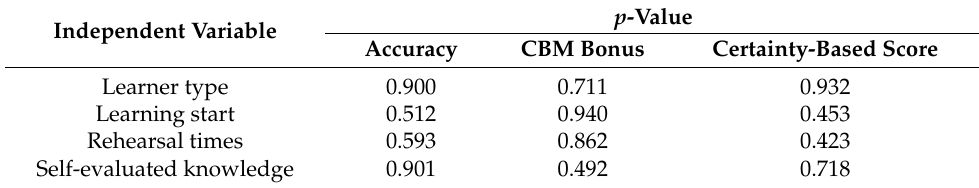
Table 1. Results of mean-comparison tests between different student’s qualities (Learner type, Learning start, Rehearsal times, Self-evaluated knowledge) and performance indicators (Accuracy, CBM Bonus and Certainty-Based